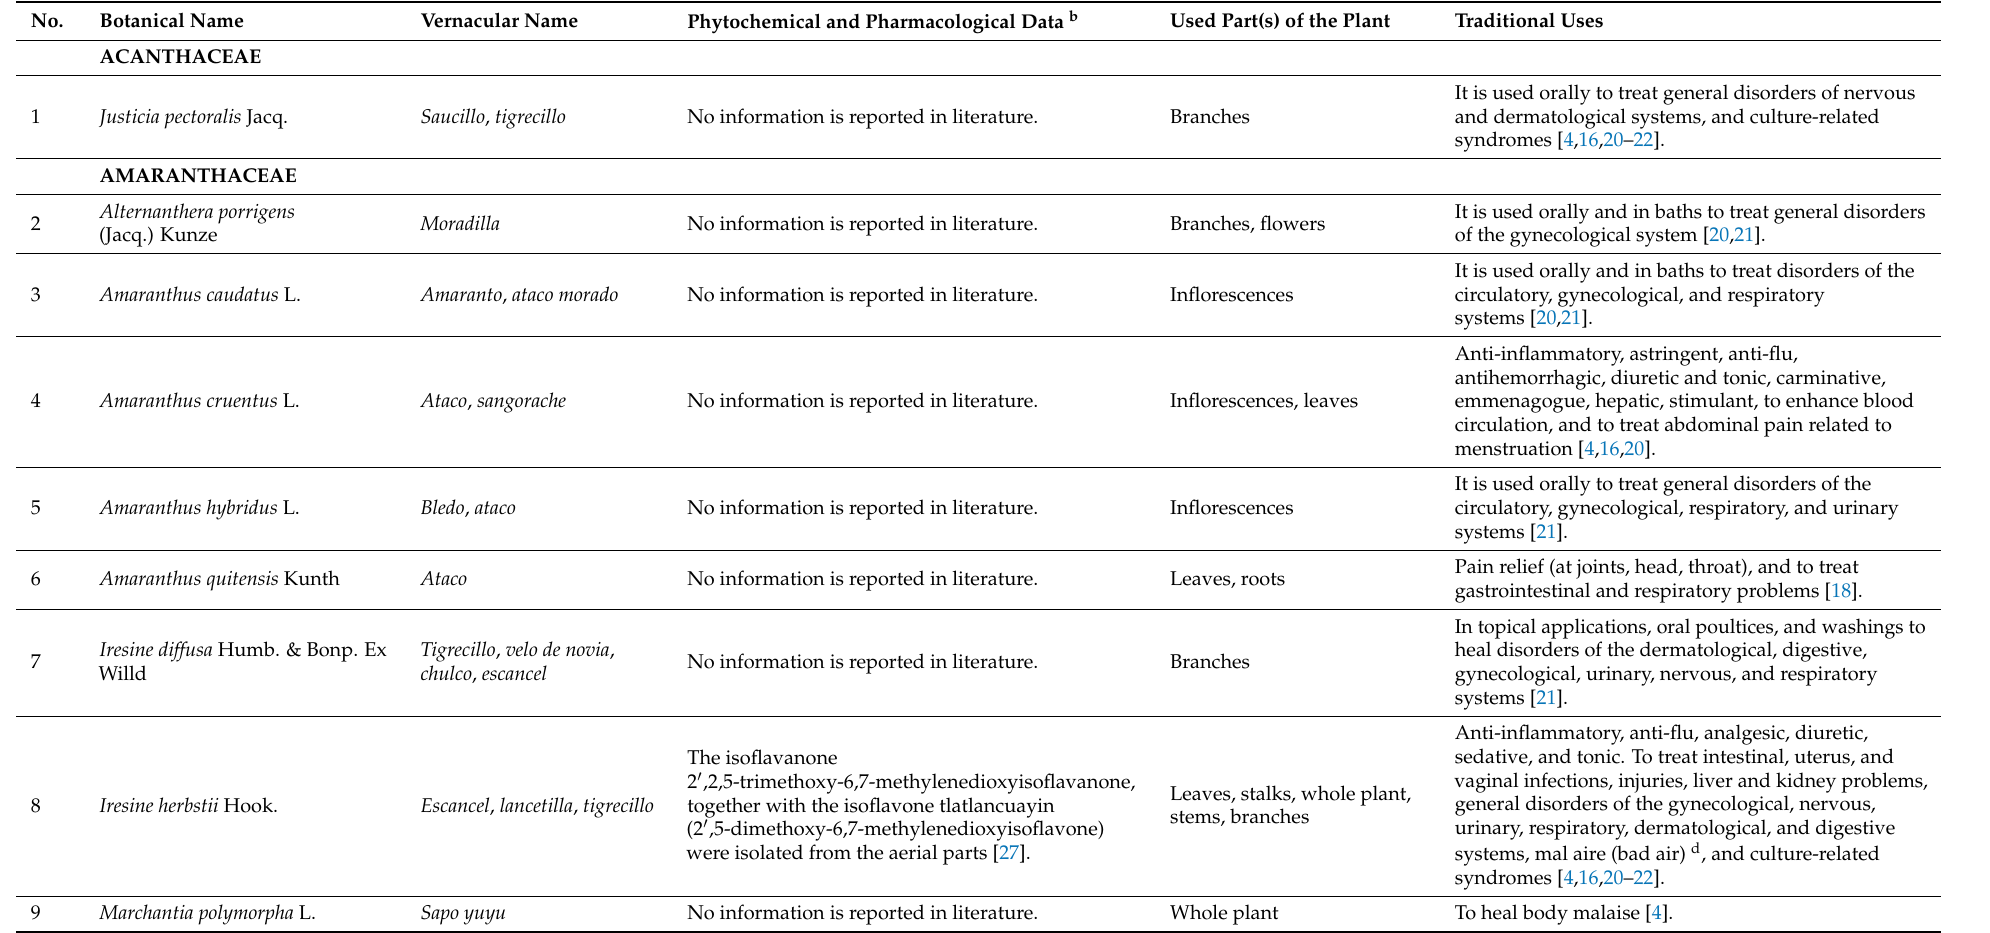
Table 1. Botanical and vernacular names, phytochemical and pharmacological data, used part(s), and traditional uses of native and endemic medicinal plants of Ecuador a